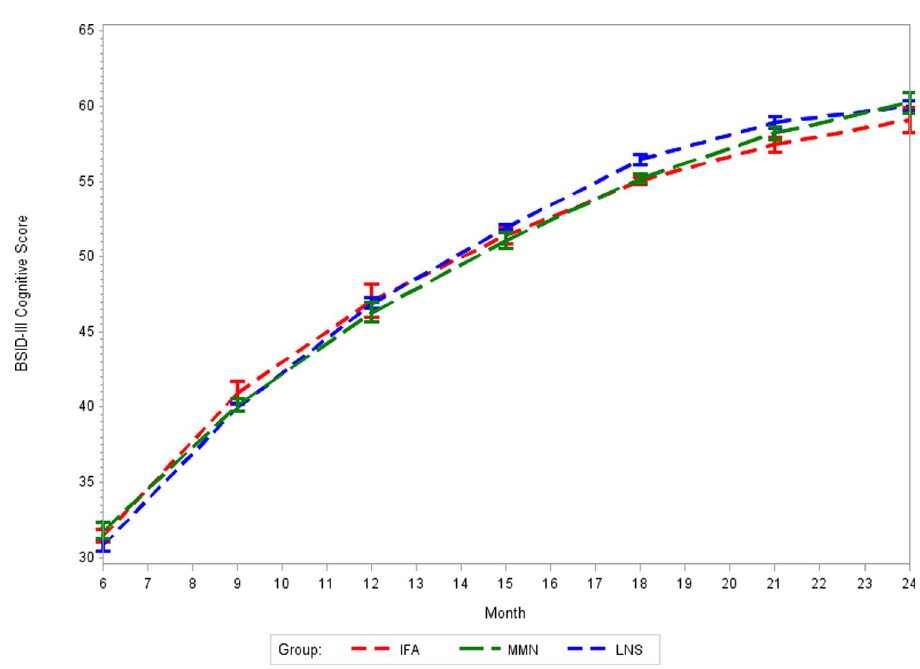
Fig 3. Mean BSID-III cognitive scores from 6 to 24 months for MMS, LNS, and IFA groups. p -Value for difference in trajectory: MMS vs. IFA = 0.28; LNS vs. IFA < 0.001. BSID-III, Bayley Scales of Infant and Toddler Development III; IFA, iron–folic acid supplements; LNS, lipid-based nutrient supplements; MMS, multiple micronutrient supplements.